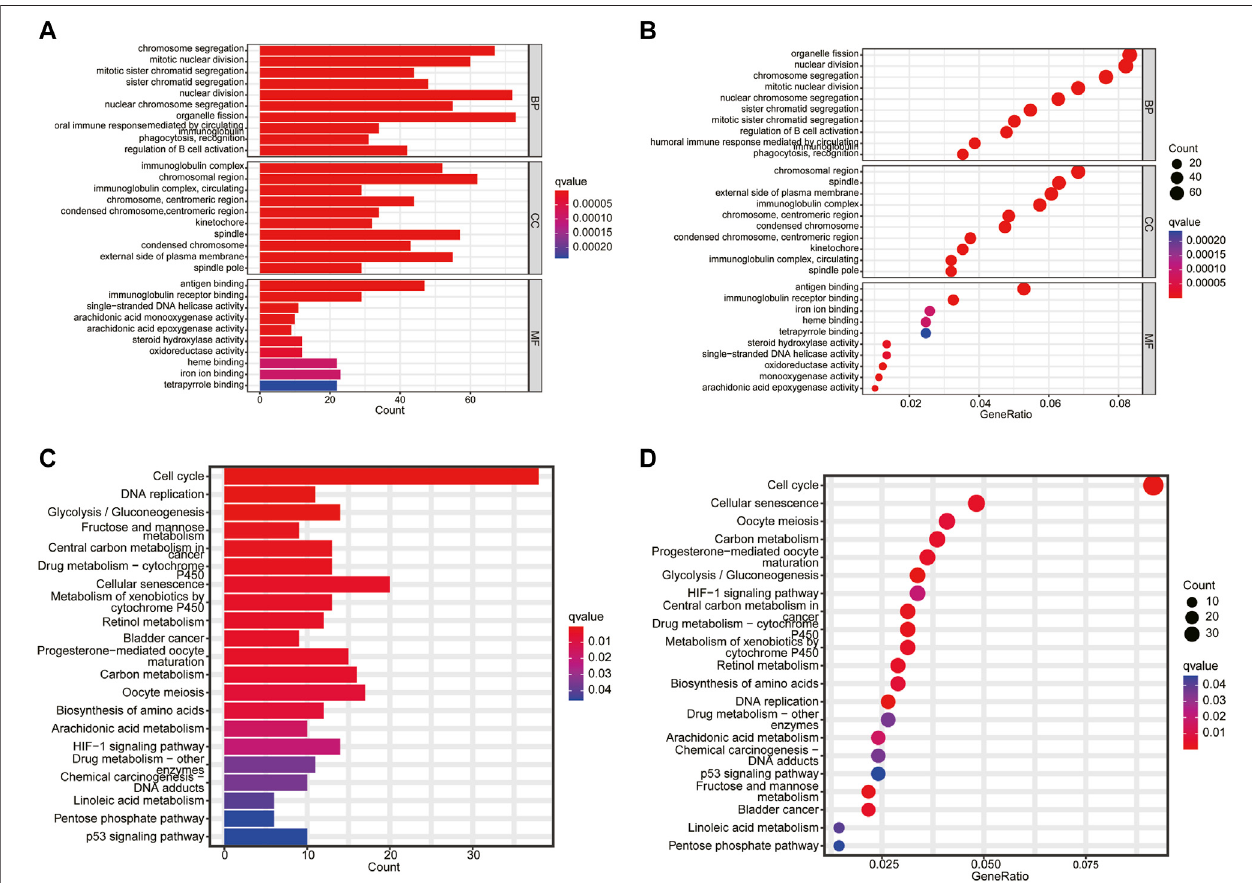
FIGURE 7 | Functional enrichment analysis. (A,B) The top 10 biological process (BP) terms, CC terms, and MF terms of gene ontology analysis. (C,D) Kyoto Encyclopedia of Genes and Genomes enrichment analysis indicating related genes and pathways.